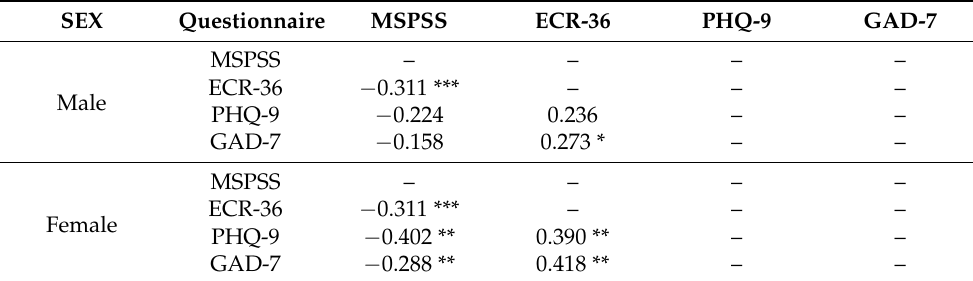
Table 2. Pearson correlations between the variables used in the mediation model dividing by